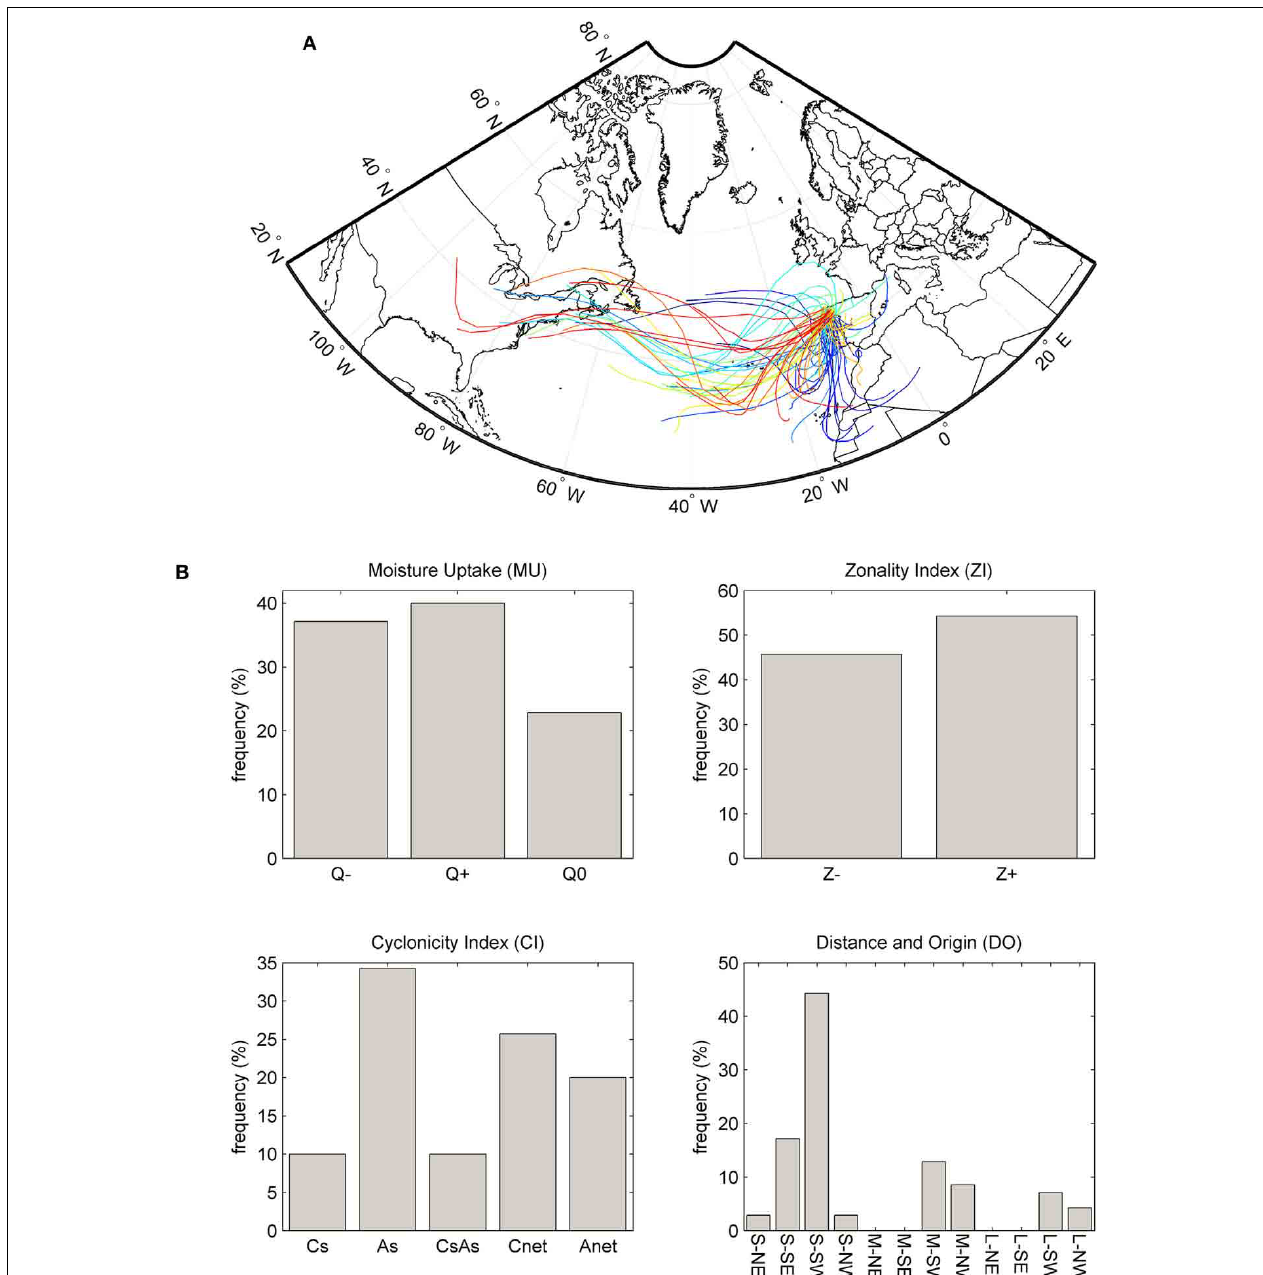
FIGURE 7 | (A) Air streams (each color represent a different day) and (B) characteristics of the trajectory types classification for the heatwave case study (01/08/2003 to